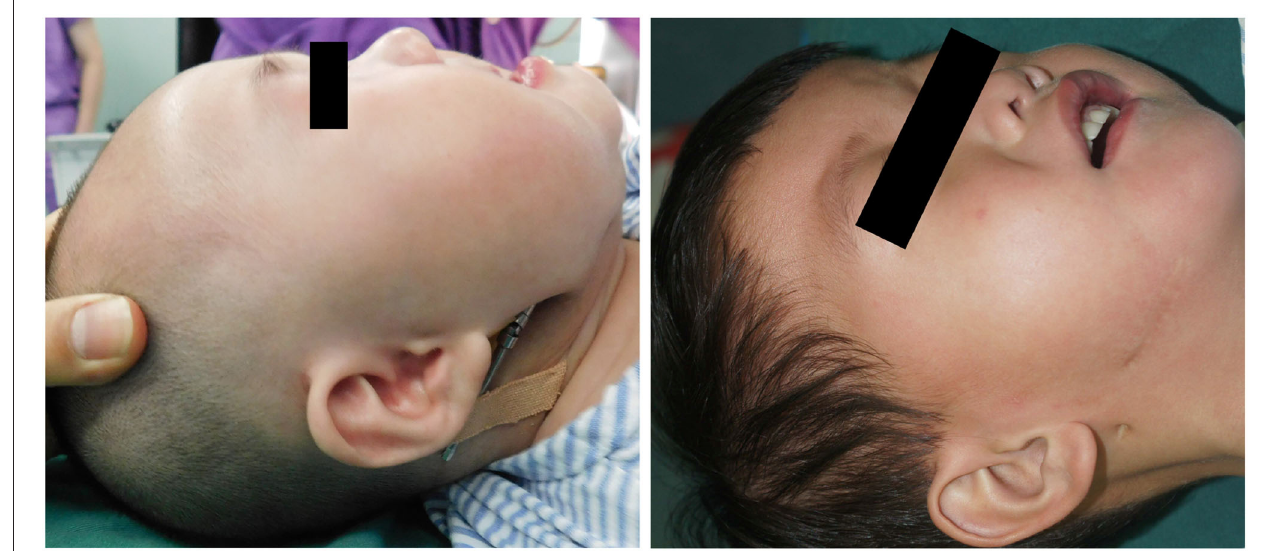
FIGURE 3 | The 3 months and 1 year